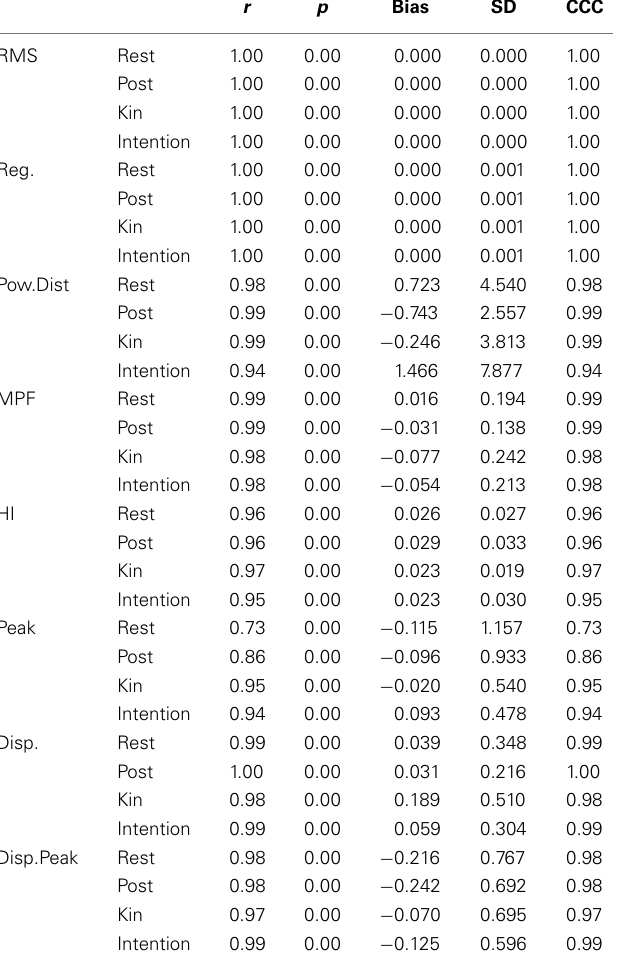
Table 2 | Correlation coefficients between the results obtained from the algorithms imbedded within the smart phone and the results obtained from the analysis of the time series from the laboratory accelerometer by our analysis package using the S-Plus software. Without With threshold threshold